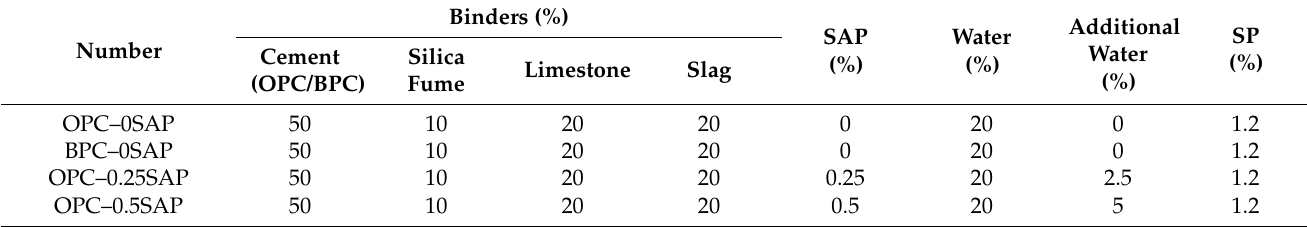
Table 3. Mixture design of sustainable ultra-high-performance paste (SUHPP).